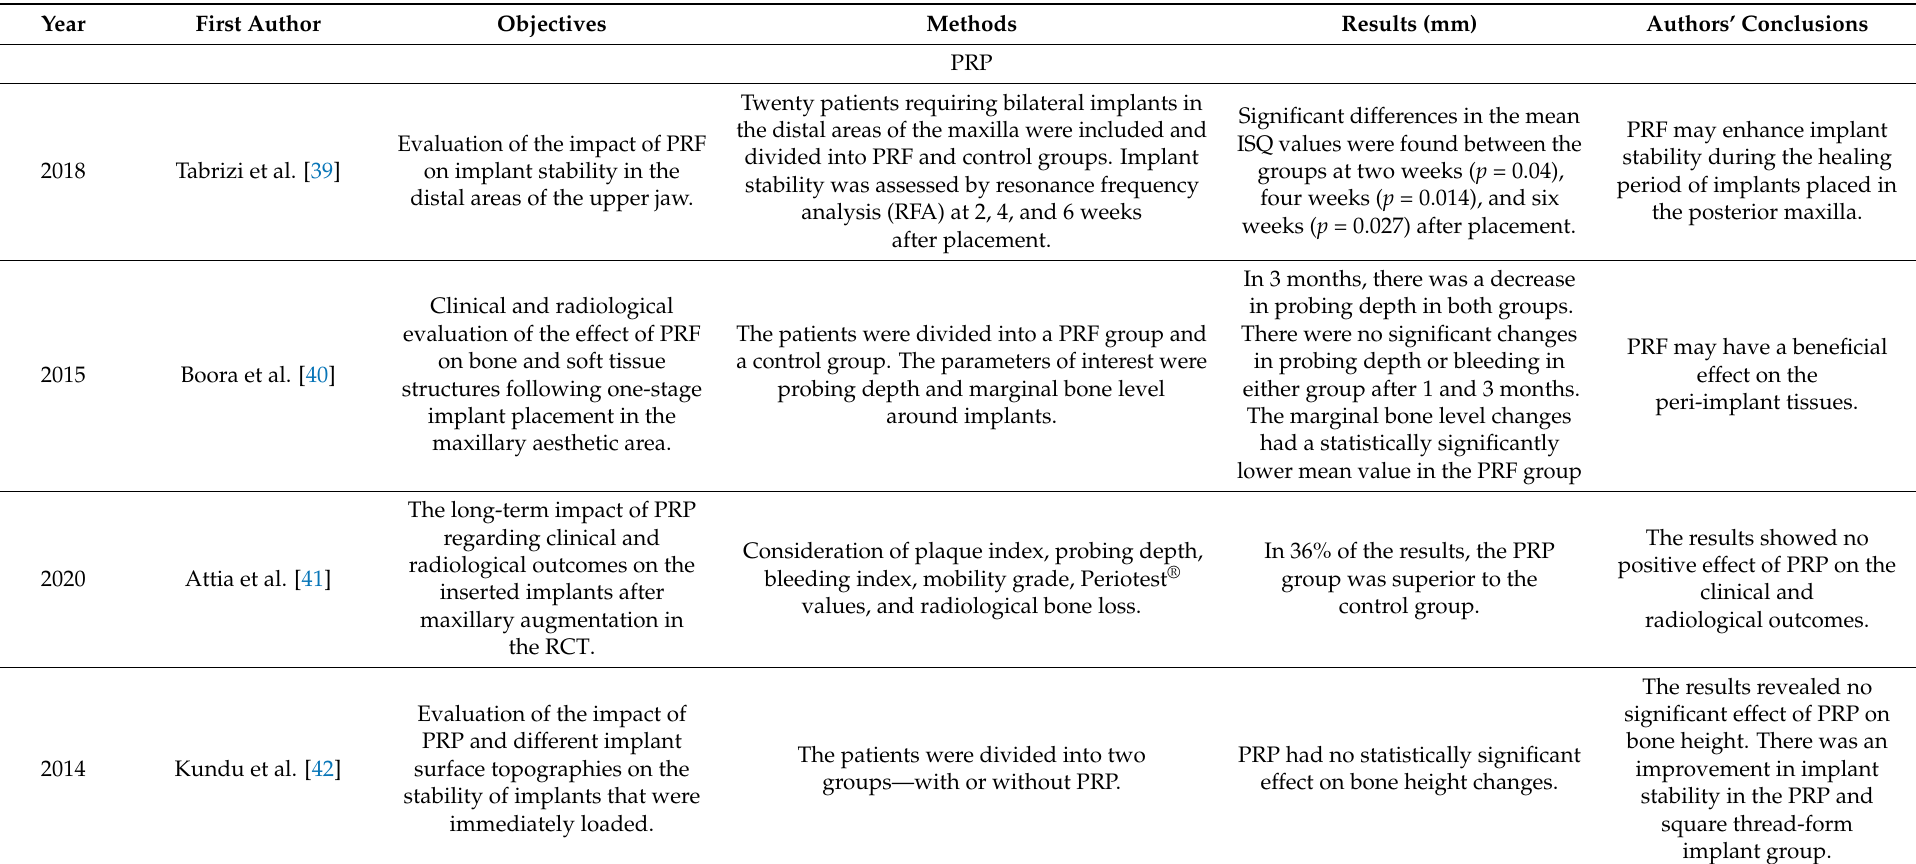
Table 1. Comparison between the 3 APC techniques (PRP, PRF, and CGF) in dental